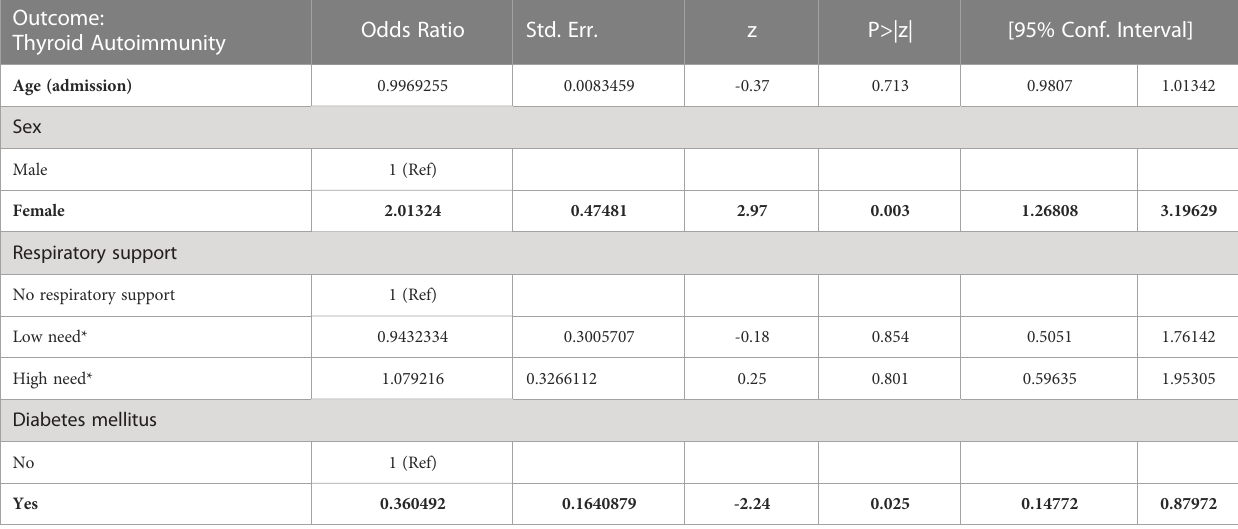
TABLE 2 Multivariable analysis of factors correlated with thyroid autoimmunity in the cohort of COVID-19